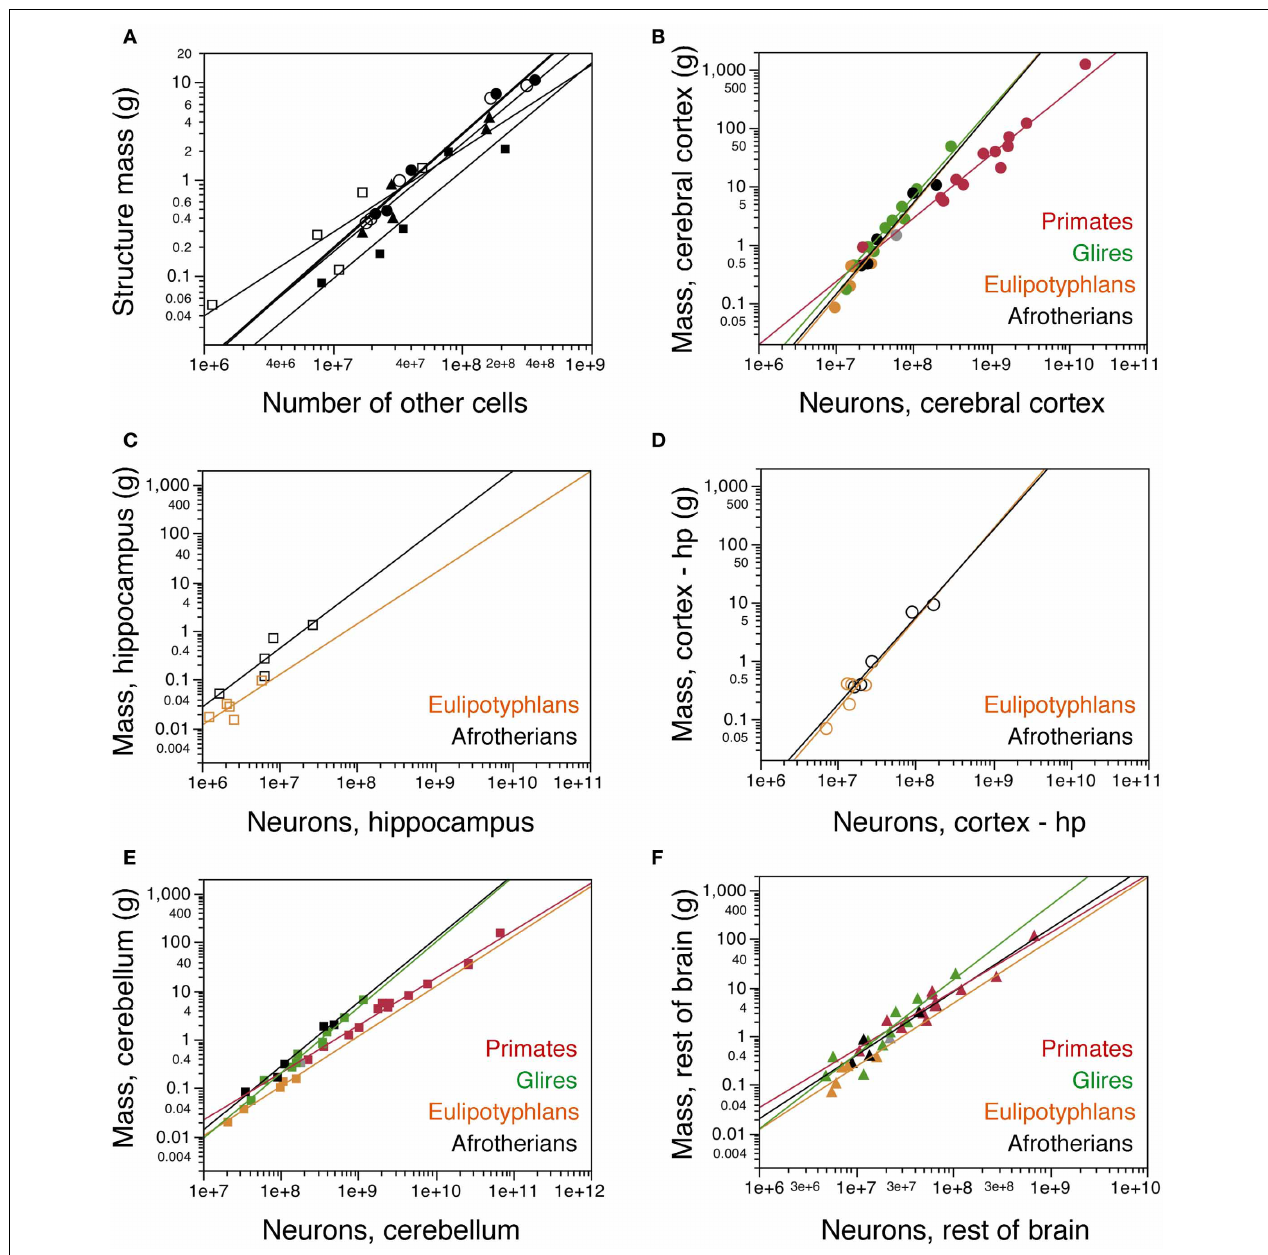
FIGURE 4 | Cellular scaling rules for afrotherian brain structures. (A) Average mass of each brain structure is plotted for each afrotherian species as a function of its total number of other (non-neuronal) cells. Power functions are plotted separately for each structure, and have similar exponents of 1.179 ± 0.091 (cerebral cortex without hippocampus, open circles), 1.182 ± 0.109 (cerebral cortex with hippocampus, filled circles), 1.112 ± 0.214 (cerebellum, filled squares), 0.862 ± 0.239 (hippocampus, open squares), and 1.119 ± 0.168 (rest of brain, triangles). (B–F) Average mass of each brain structure plotted for each species as a function of its total number of neurons. (B) cerebral cortex including hippocampus; (C) hippocampus; (D) cerebral cortex without hippocampus; (E) cerebellum; (F) rest of brain. Afrotherian species shown in black, primates in red, scandentia in gray, glires